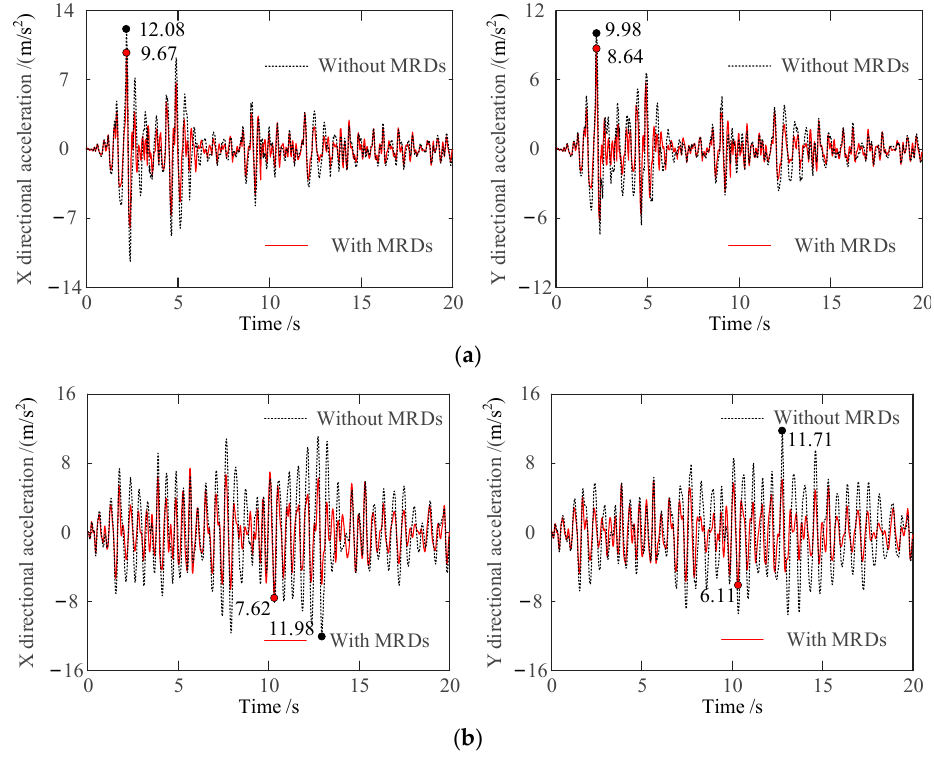
Figure 10. Comparison of horizontal bidirectional total acceleration response of node 24 of RC frame structure. ( a ) Under the action of El-Centro wave; ( b ) under the action of Tangshan wave. Figure 10a shows that under the action of the El-Centro wave, the X and Y directional maximum accelerations of the top node in the RC structure were 12.08 m/s 2 and 9.98 m/s 2 , respectively. After setting the MRD in the structure, the X and Y directional maximum accelerations of the top node in the RC structure were 9.67 m/s 2 and 8.64 m/s 2 , which were reduced by 19.96% and 13.50%, respectively. Under the action of the Tangshan wave shown in Figure 10b, the X and Y directional maximum accelerations of the node 24 in the RC structure were 11.98 m/s 2 and 11.71 m/s 2 , respectively. After setting the MRD in the